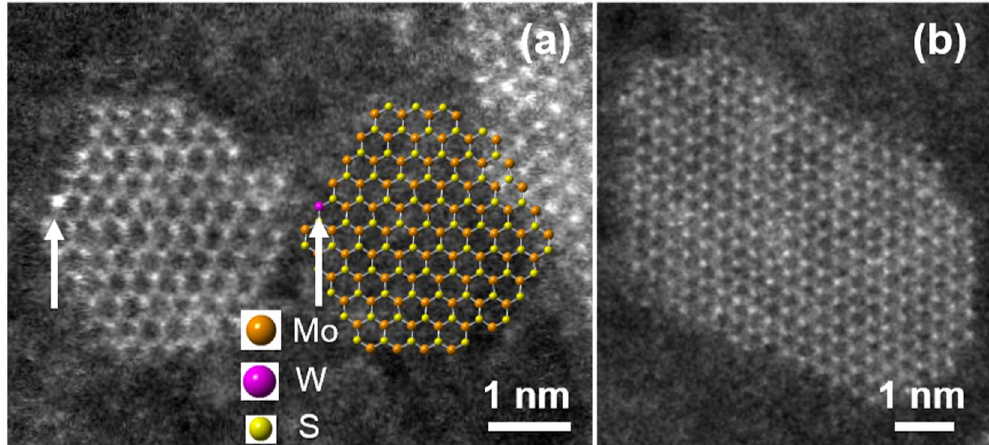
Figure 4. ( a , b ) An atomic-scale ADF-STEM image and crystal model (right side) of two small atomic clusters of MoS